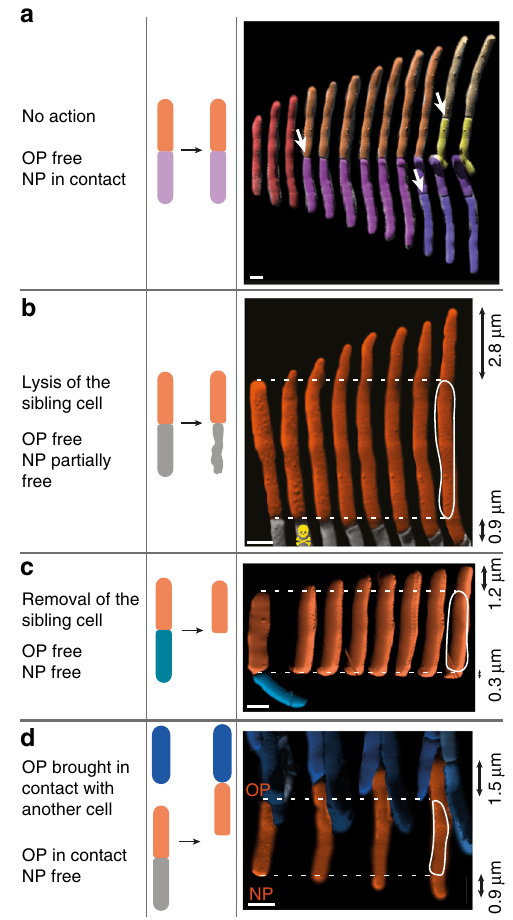
Fig. 4 The pre-NETO phase is not due to physical constraints on new cell poles. a – d Schematics and corresponding time-lapse AFM of growing M. smegmatis cells. Black arrows indicate the cumulated elongation of the old pole (OP) and the new pole (NP). Scale bar, 1 μ m. a Close contact of new poles of newborn sibling cells is maintained after division of the mother cell (white arrows). b Elongation of cell poles after the new pole was partially freed by ablating the turgor pressure in one of the sibling cells using the sharp AFM tip (skull). c Elongation of cell poles after the new pole was freed by removal of one of the sibling cells using the AFM cantilever. d Elongation of cell poles after the new pole was freed and the old pole was physically obstructed by moving it into contact with other cells using the AFM